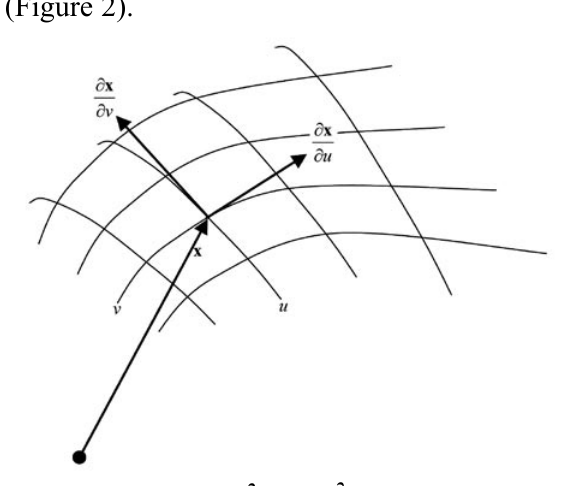
Figure 2 The derivatives and are vectors tangent to the u- and v- parameter curves of the surface at the point with position vector x